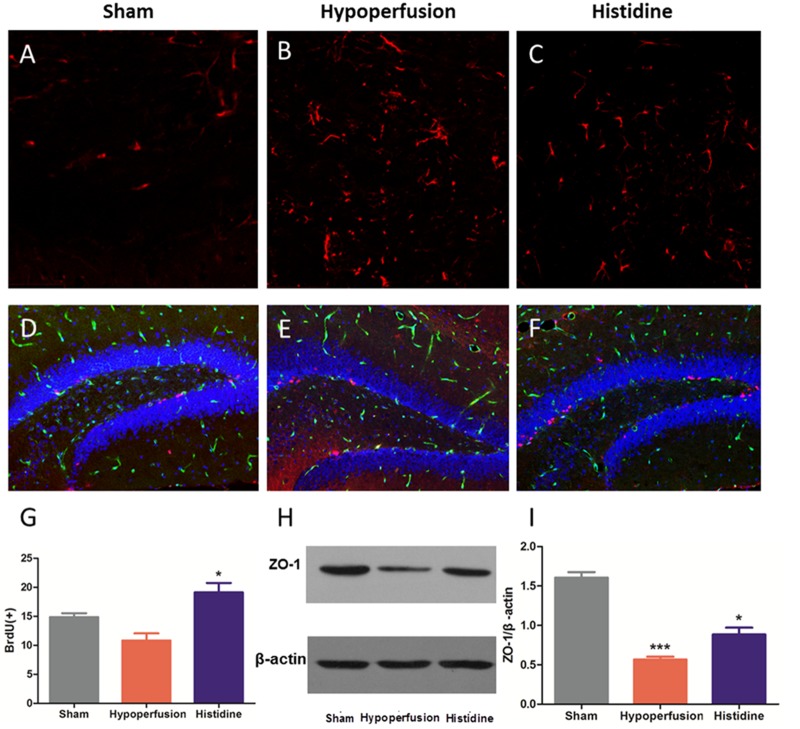
Histidine increases neurogenesis and ZO-1 protein expression. (A–C) Astrocytes (labeled with red fluorescence) were activated after hypoperfusion, and histidine decreased the activation. (D–F) New-born cells labeled with red fluorescence slightly decreased after hypoperfusion, which was reversed significantly by histidine (n = 6, ∗p < 0.05 Histidine vs. Hypoperfusion). Vascular endothelial cells were labeled with green fluorescent. All the cell nucleuses were labeled with blue fluorescence. (G) The new-born cells labeled with BrdU+ were increased significantly after histidine administration (n = 6, ∗p < 0.05 vs. Hypoperfusion). (H) The expression of ZO-1 was decreased after hypoperfusion, and partially recovered after histidine administration. (I) The expression level of ZO-1/β-actin decreased significantly after hypoperfusion (n = 6, ∗∗∗p < 0.05 Hypoperfusion vs. Sham). The expression level was increased significantly when using histidine (n = 6, ∗p < 0.05 Histidine vs. Hypoperfusion).